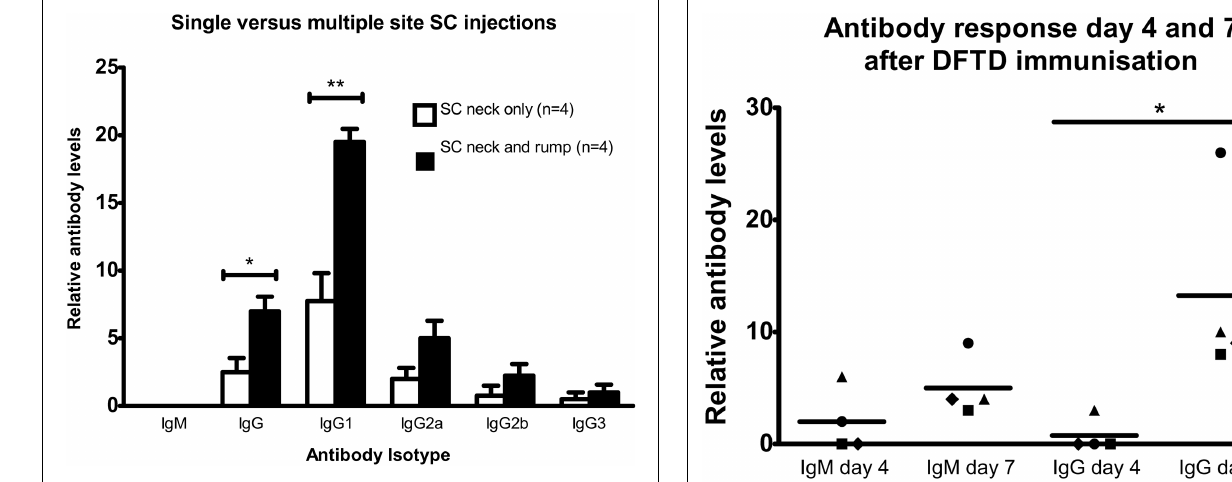
FIGURE 2 | Comparison of antibody responses of BALB/c mice injected twice subcutaneously with 10 6 DFTD cells into a single site, or divided equally between two sites on days 0 and 16, with serum collected day 25 . Mean fluorescence intensity ratio of samples compared to pooled naïve mouse serum was used as a relative measure of antibody production. IgM was not detected in any sample (Data are expressed as mean ± SEM; probability calculated by an unpaired Student’s t -test * P < 0.05, ** P < 0.01).